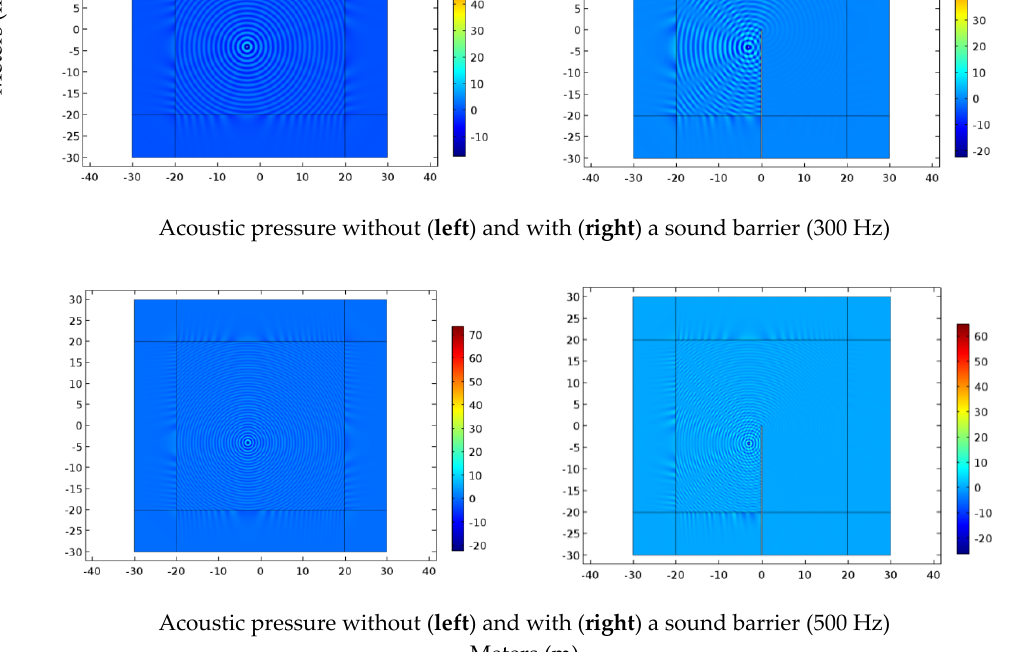
Figure 3. Acoustic pressures of the domain calculated via FEM for different frequencies. Colorbar units are in Pascal (Pa). Axis units are in meters (m).